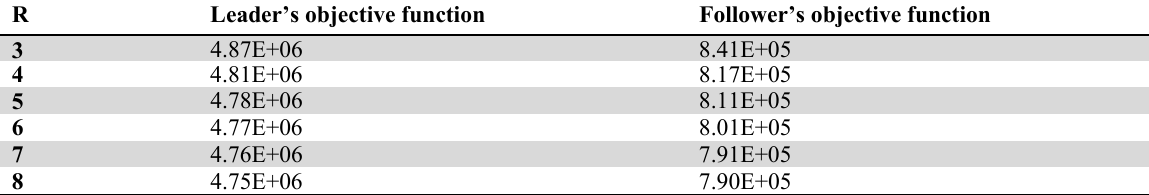
Fig. 4. Impact of warehouse capacity on the amount of transportation costs Impact of warehouses radius coverage on optimal bi-level model